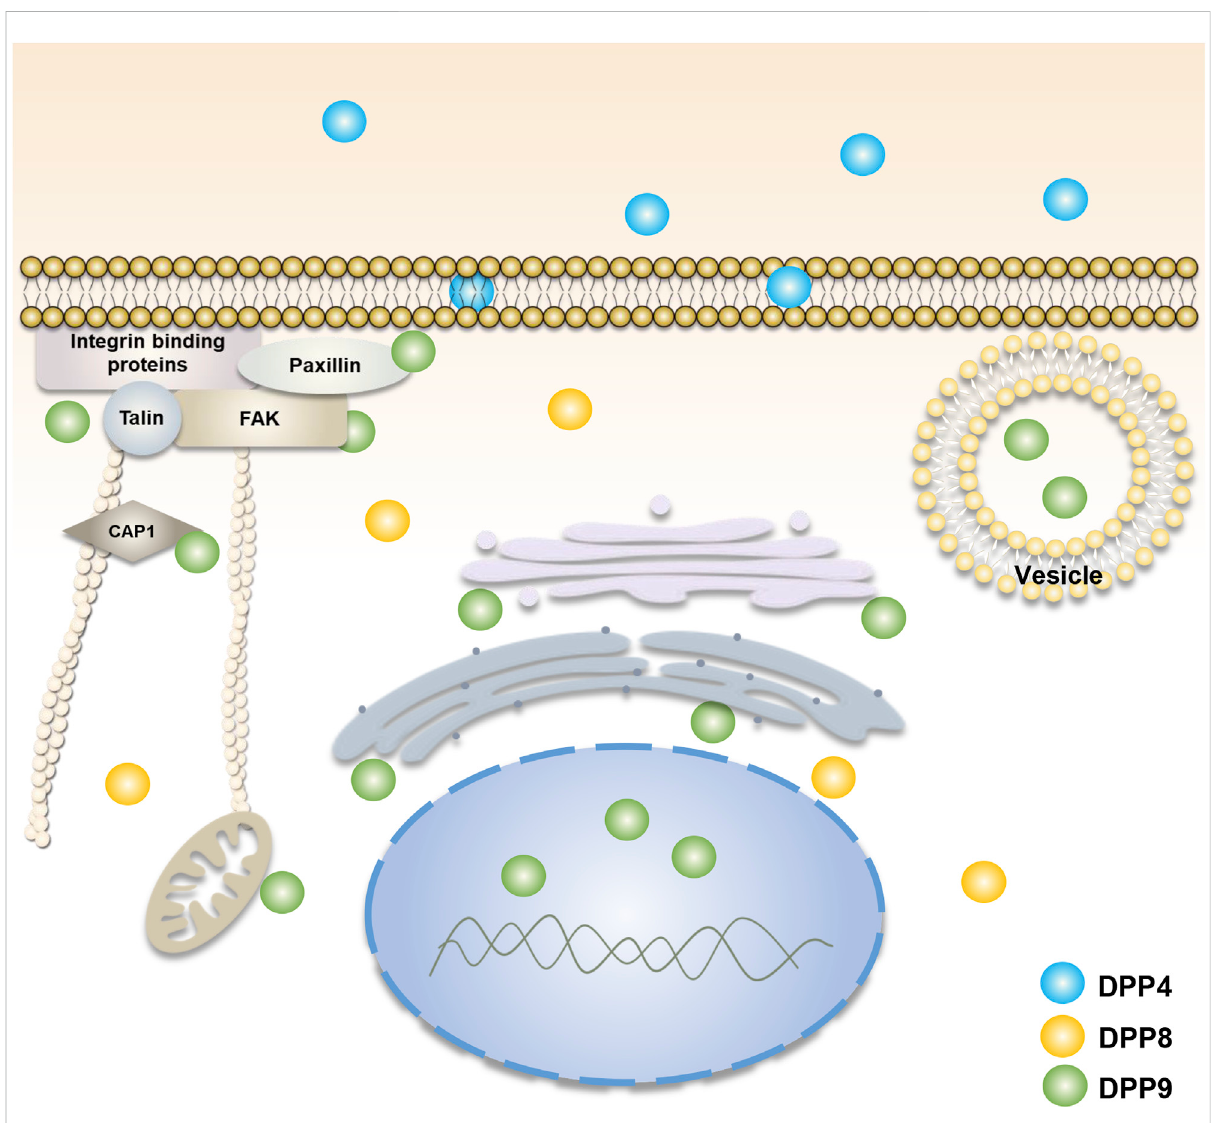
FIGURE 1 Cellular localization of DPP4, DPP8, and DPP9. DPP4 (blue) is mainly found in cell membranes and body fl uids. DPP8 (yellow) and DPP9 (green)